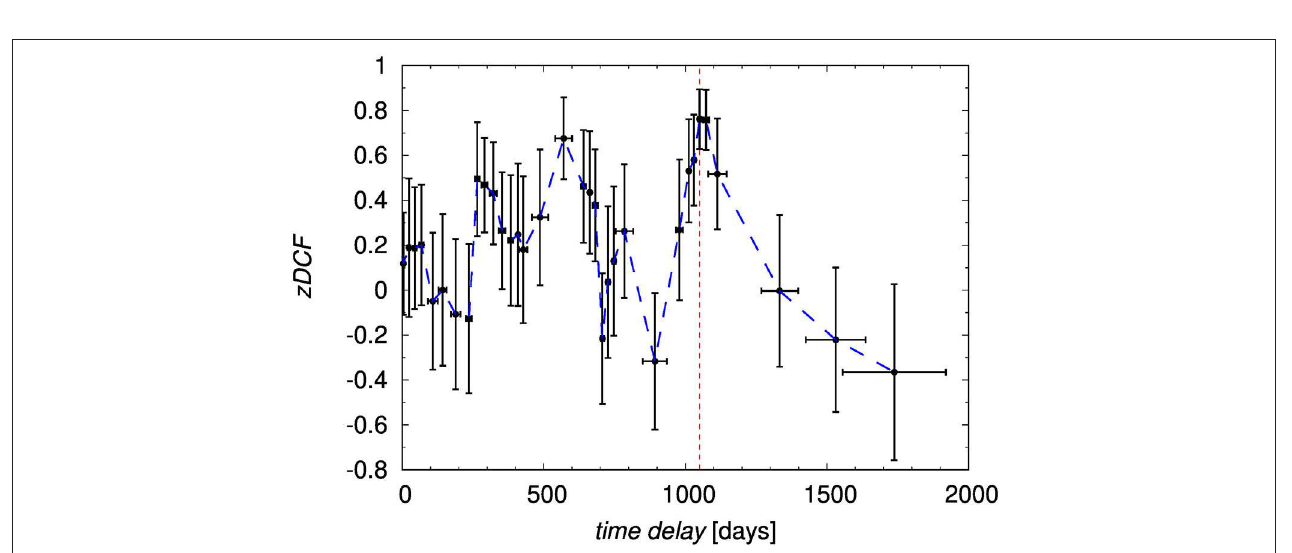
days. 1030 + 106 = − 140